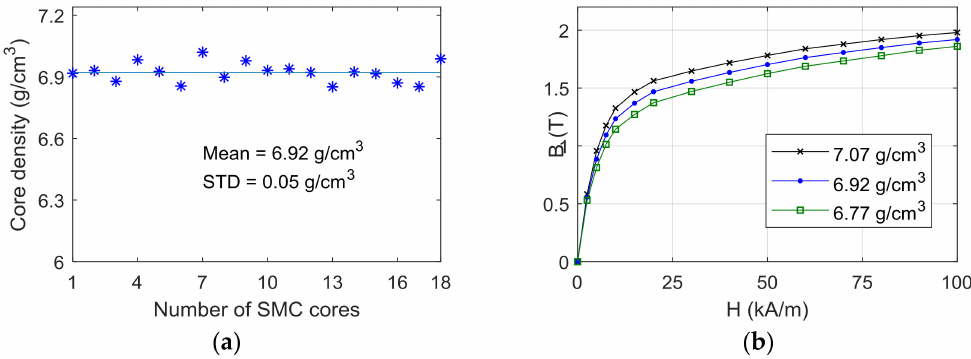
Figure 7. ( a ) SMC core density variation, ( b ) magnetization curves vs core